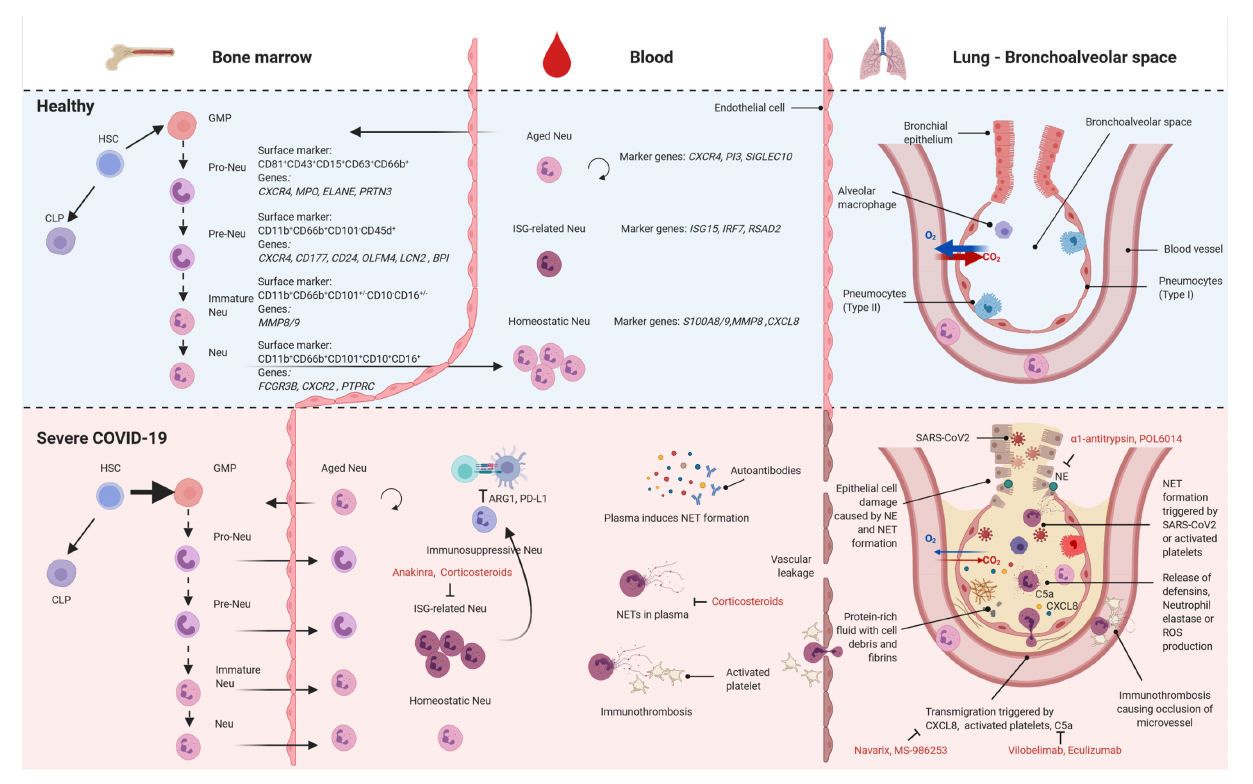
FIGURE 1 | Neutrophil subsets in health and severe COVID-19. Overview of the different subsets of neutrophils found in bone marrow (left), blood (center) and lung (bronchoalveolar space, right) in health (top) and severe COVID-19 (bottom). HSC, hematopoietic stem cells; CLP, common lymphoid progenitors; GMP, granulocyte-monocyte progenitor cell; Neu, neutrophil; ISG, interferon-stimulated genes; NET, neutrophil associated extracellular trap; ROS, reactive oxygen species; created with